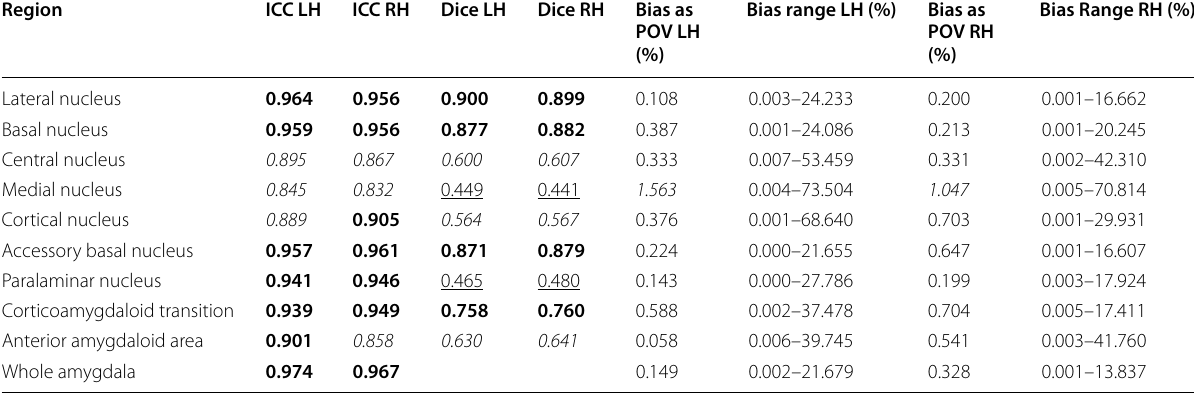
Dice coefficient for right =